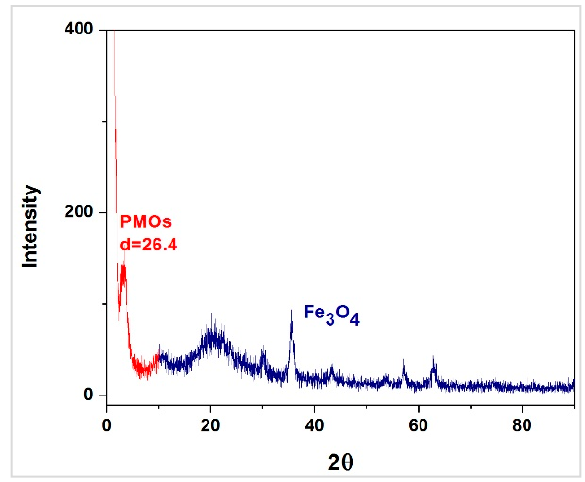
Figure 6. XRD analysis of magnetic chiral PMO nanoparticles.